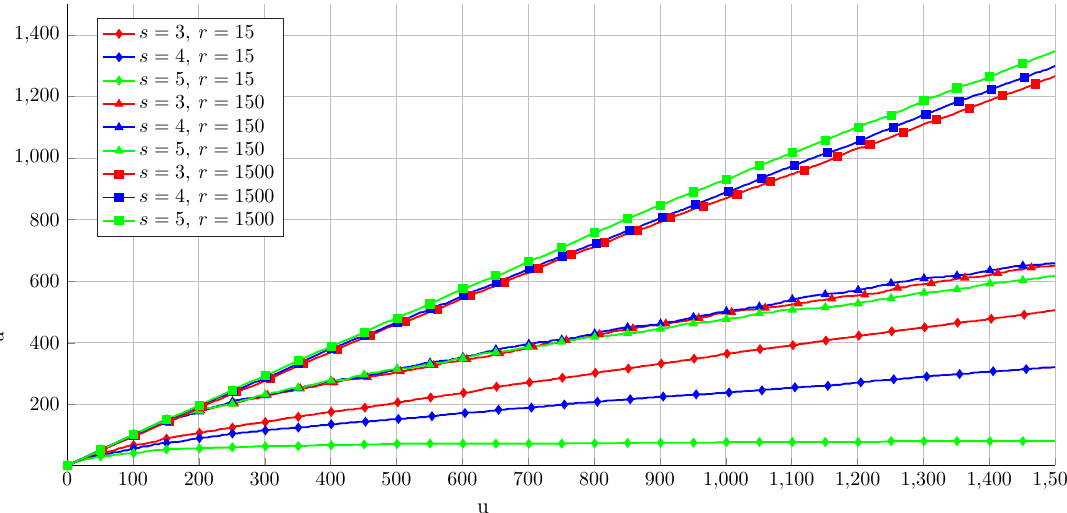
Figure 4. Number of regions versus number of iterations.